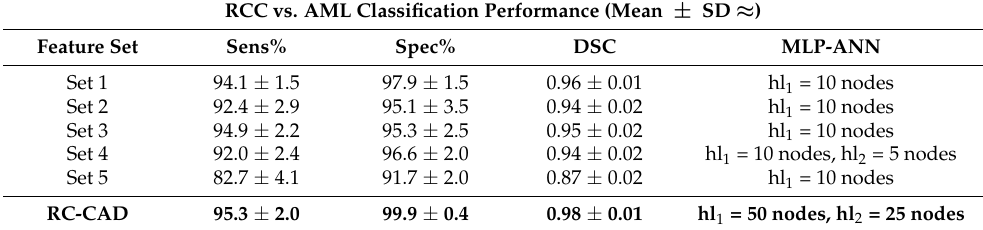
Hyperparameters: MLP-ANN (optimization function: trainlm, max epochs = 500, goal = 0, max validation failure = 6, min gradient = 10 − 7 , training gain ( µ ): initial µ = 0.001, µ decrease factor = 0.1, µ increase factor = 10, max µ = 1e 10 ).